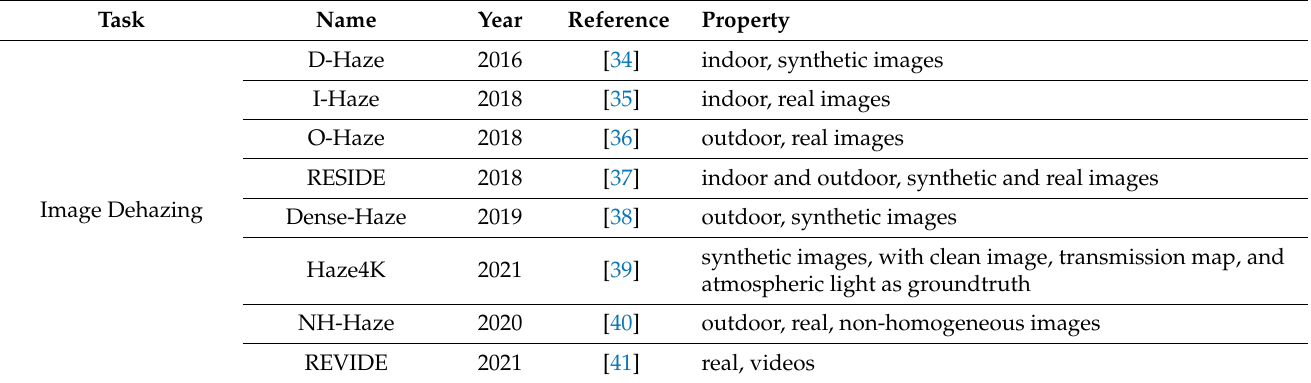
Table 2. Comparison of different fog-related